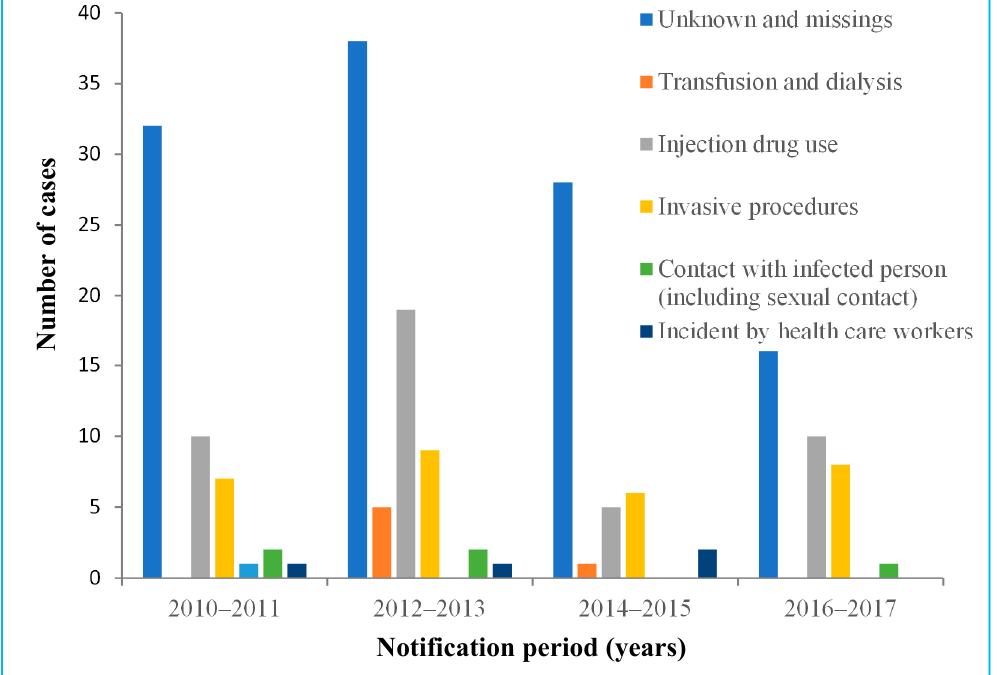
Figure 5. Number of acute hepatitis C virus cases by exposure and notification period, Vilnius and Kaunas counties, 2010–2017.